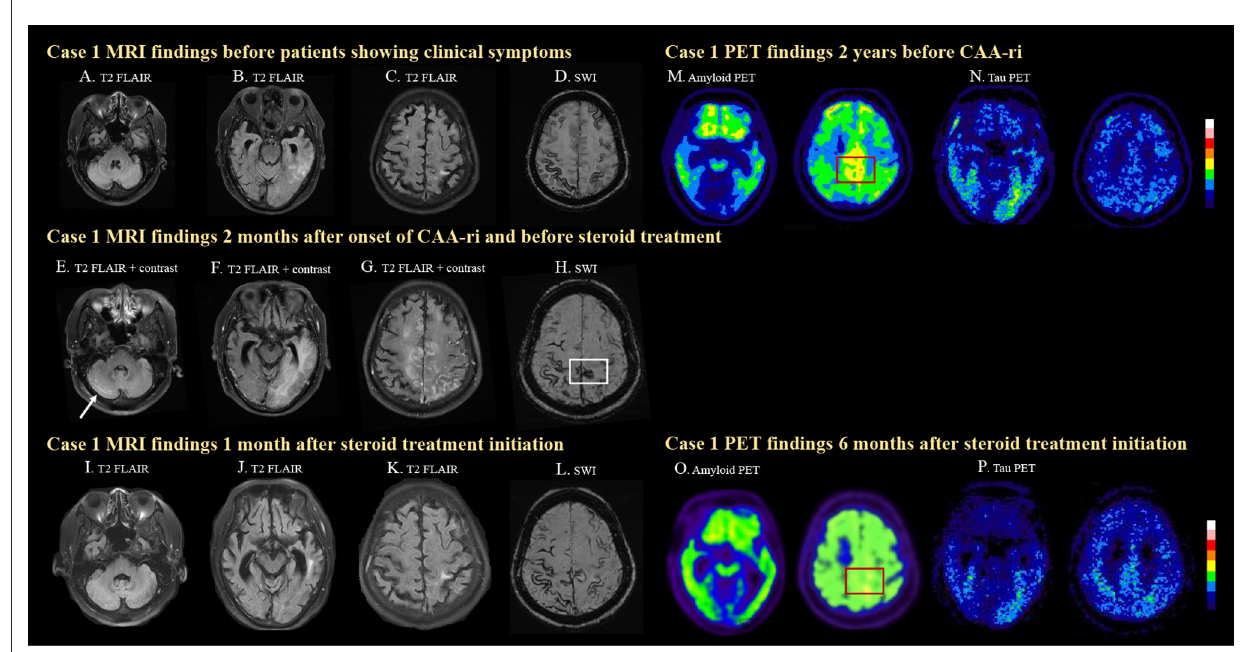
FIGURE1 MRI and PET images for case 1. The case was diagnosed as probable CAA after a symptomatic left temporal ICH with disseminated cortical superficial siderosis (cSS) on MRI (A–D) . Two months prior to his clinical symptoms, mild left temporal T2 FLAIR hyperintensity was already seen (B) , which may suggest insidious onset of ARIA-E. The patient then developed progressive lethargy and spontaneous ARIA-E, showing white matter hyperintense lesions with leptomeningeal enhancement and mass effects in the right cerebellum [ (E) , arrow], left temporal (F) , bilateral medial frontal, and parietal lobes (G) on T2 FLAIR images before steroid treatment. A newly developed cSS in the posterior medial frontal region [ (H) , white box] was observed on SWI, which was not seen 2 months earlier (D) . The cerebral edema significantly improved after steroid treatment (I–K) . Progressively disseminated cSS was also observed (L) . High amyloid deposition in the posterior medial frontal region was detected on amyloid PET 2 years before CAA-ri [ (M) , red box]. Amyloid deposition decreased in the medial frontal region 6 months after CAA-ri [ (N) , red box]. The patient